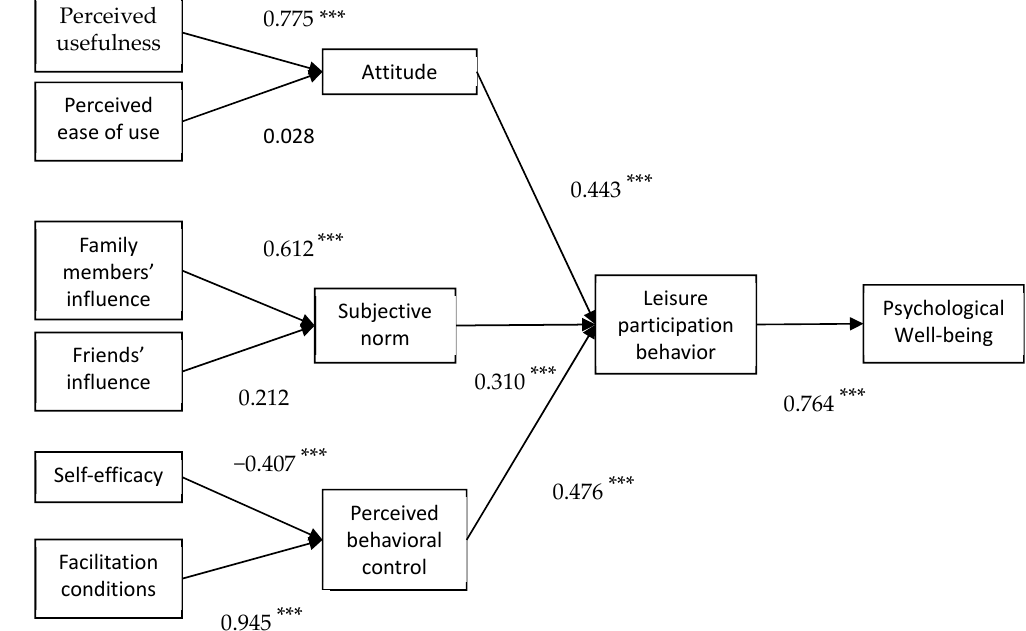
Figure 4. Results of testing hypothetical model (N = 769). * p < 0.05, ** p < 0.01, *** p < 0.001.